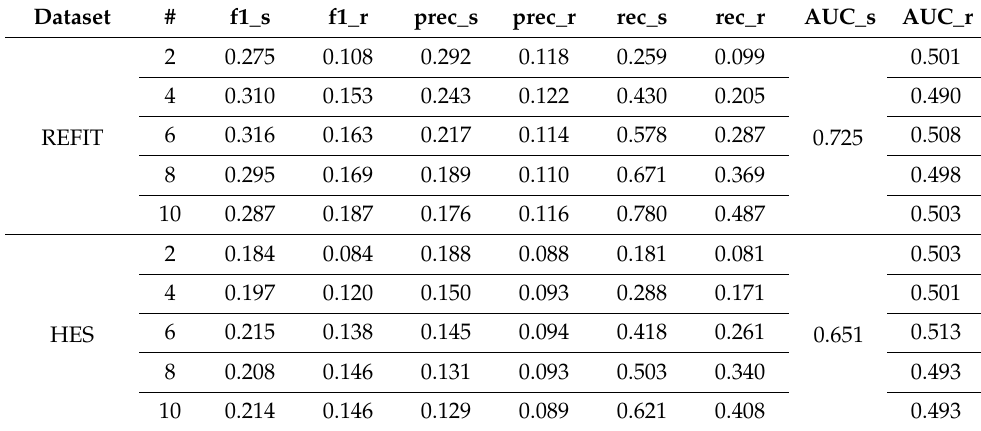
Table 6. Previous day use-single appliance (washing